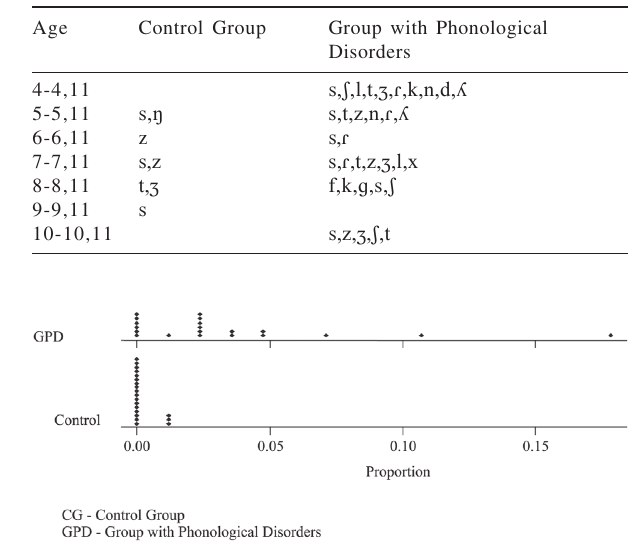
Figure 1 - Points of proportion of the distortion occurrences in the naming test.